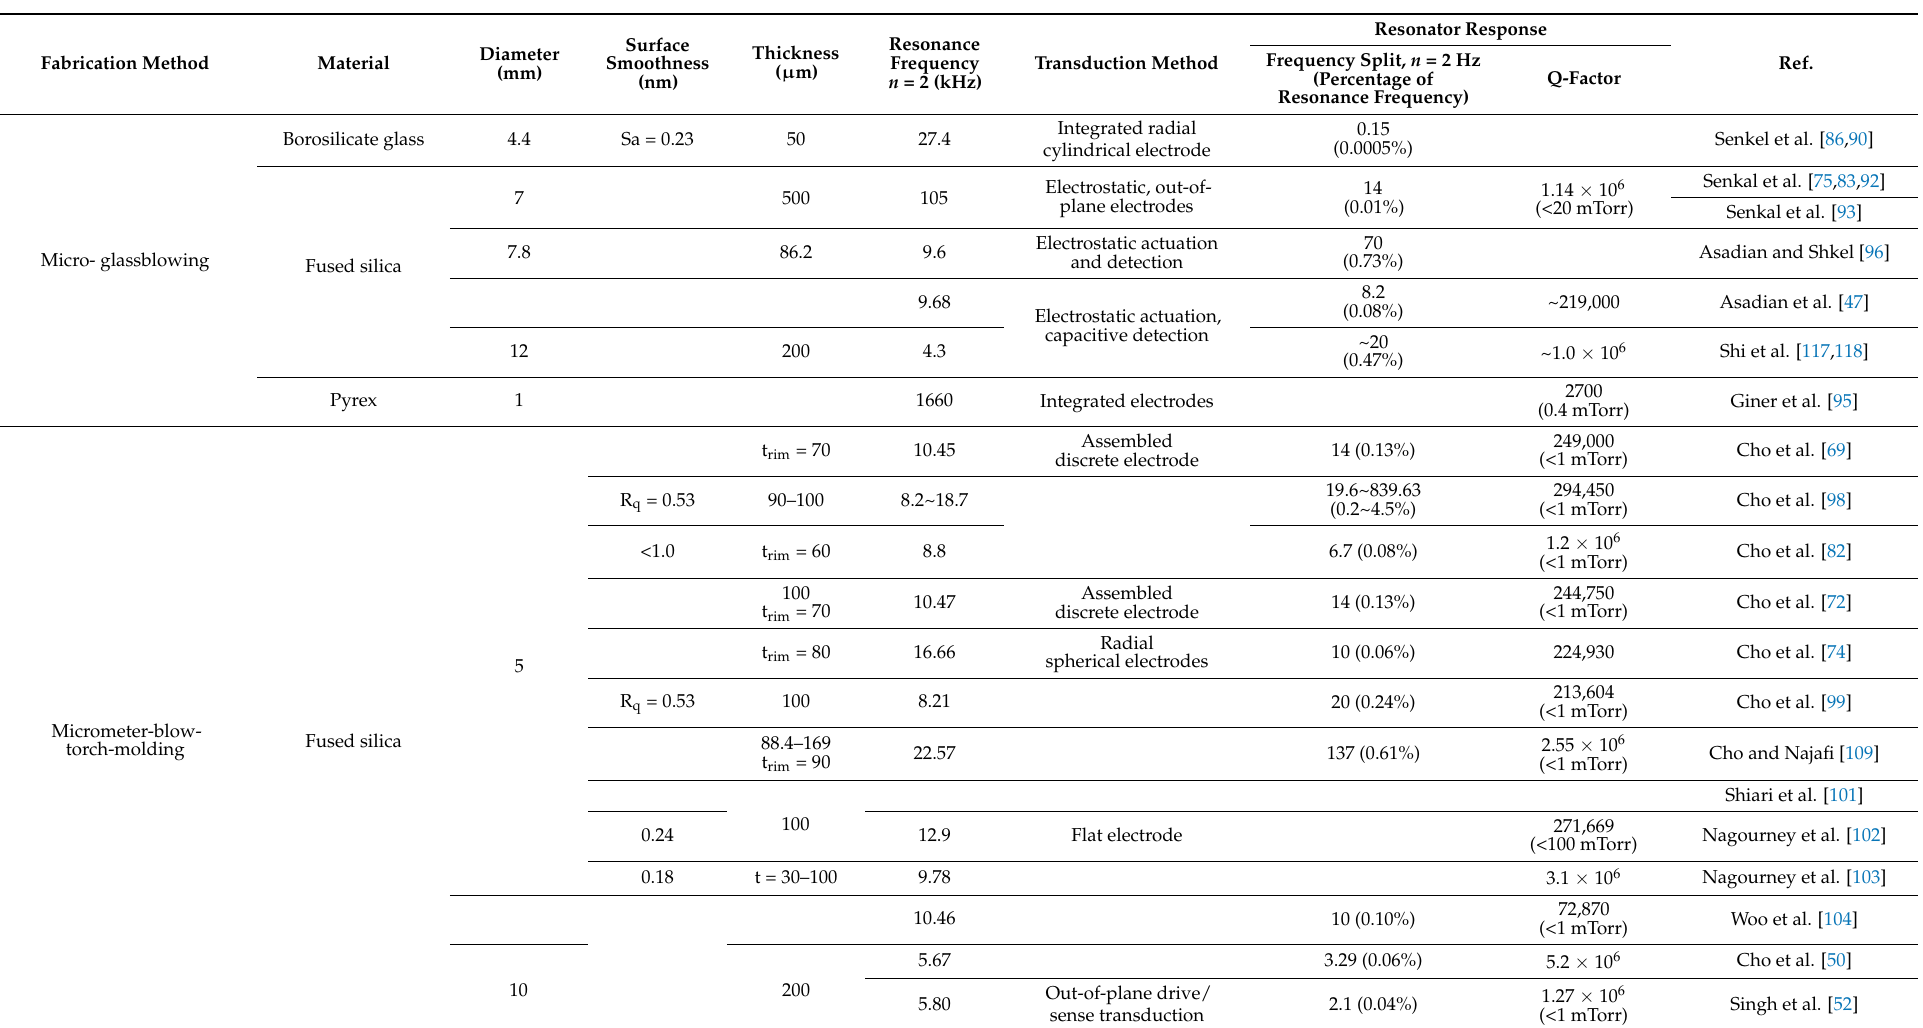
Table 1. Comparison of different HRG device